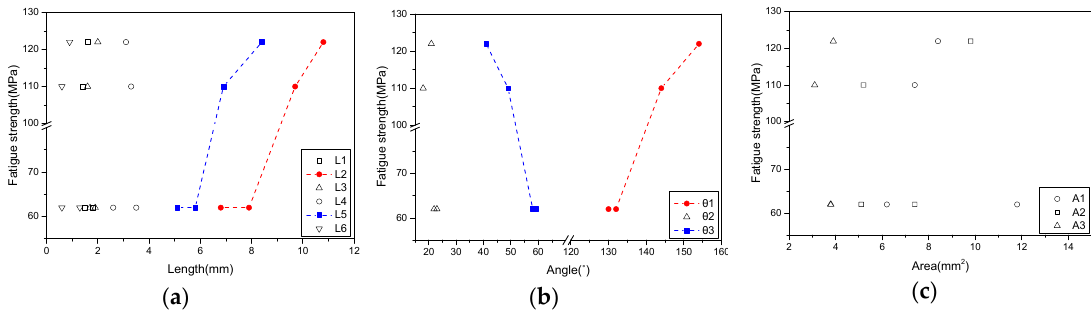
Figure 13. Relationship between weld bead shape and fatigue strength ( a ) length, ( b ) angle and ( c ) area.